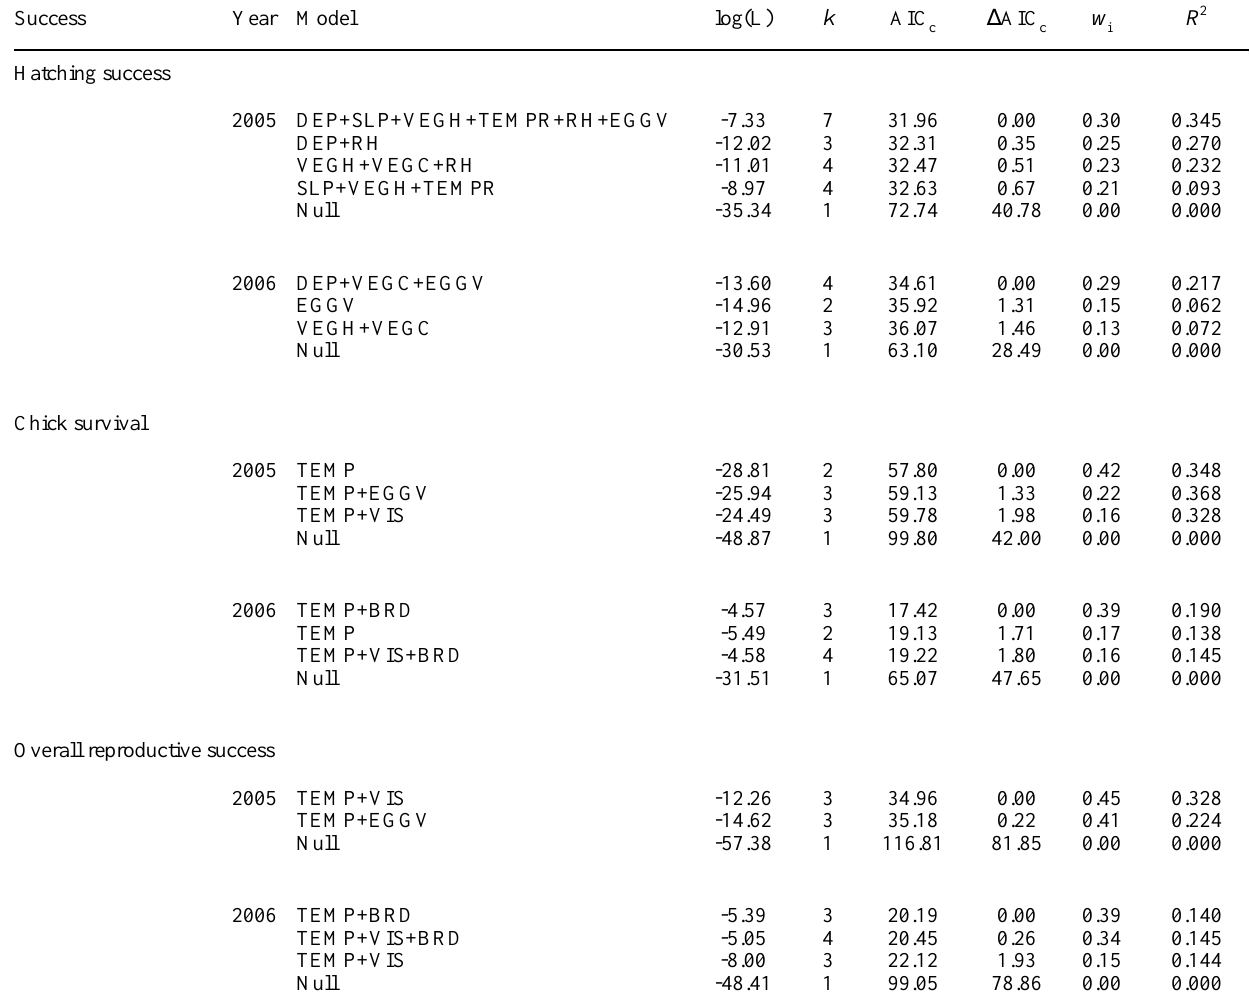
Table 1 . Summary of model selection results for logistic regression models predicting hatching success, chick survival, and overall reproductive success in Fork-tailed Storm-Petrel ( Oceanodroma furcata ) nests at Kasatochi Island, Alaska. Models are listed in order of best fit for each success parameter in each year based on Akaikeâ€™s information criterion for small sample sizes (AIC ). Except for the null model, only c models with D AIC < 2.0 are shown. Log(L) is the log-likelihood value, k is the number of parameters in c the model, D AIC is the difference in AIC value between each model and the top model, w is the Akaike c c i weight, and R 2 is the proportion of the total variation in success explained by the model. Brooding duration (BRD) data are available only for